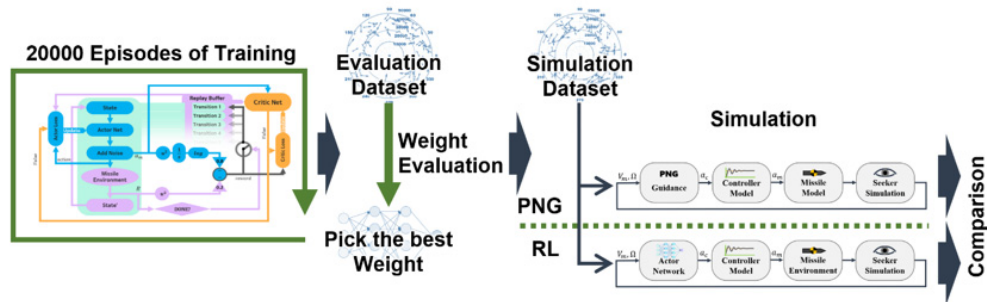
Figure 11. Flow chart of this study.